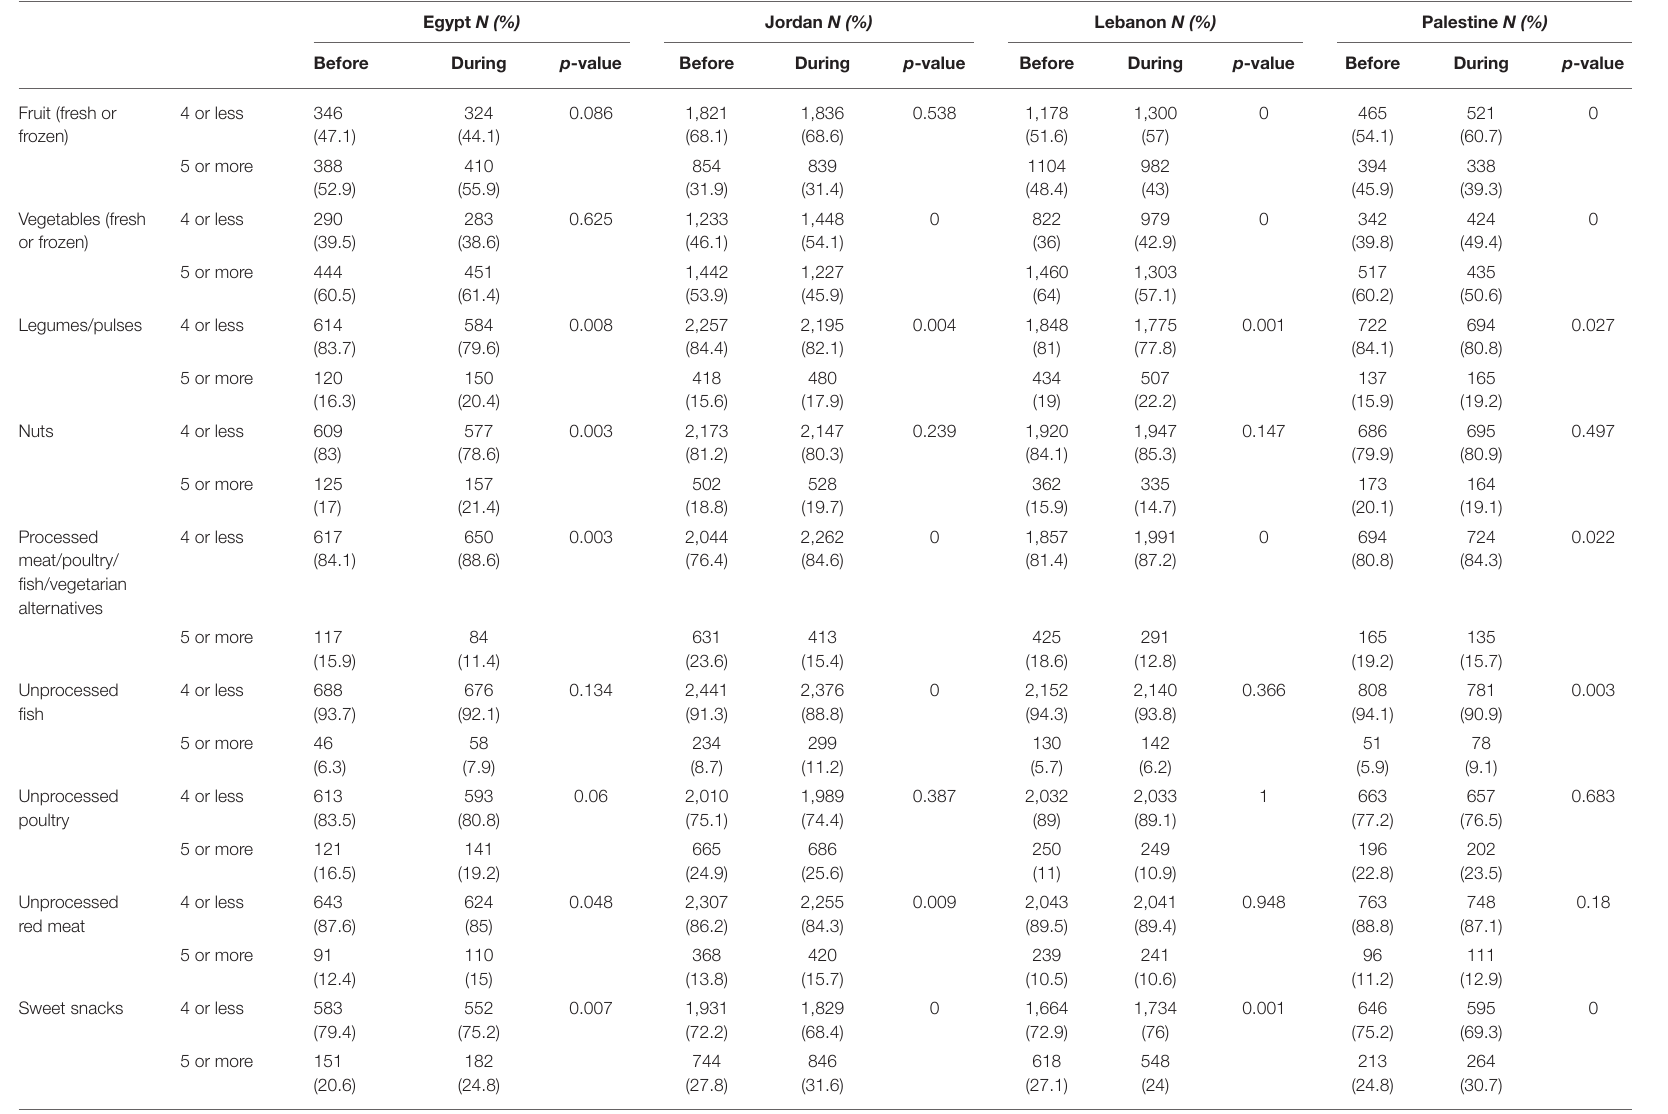
TABLE 4 | Food groups consumption among countries in the MENA region, before and during COVID-19